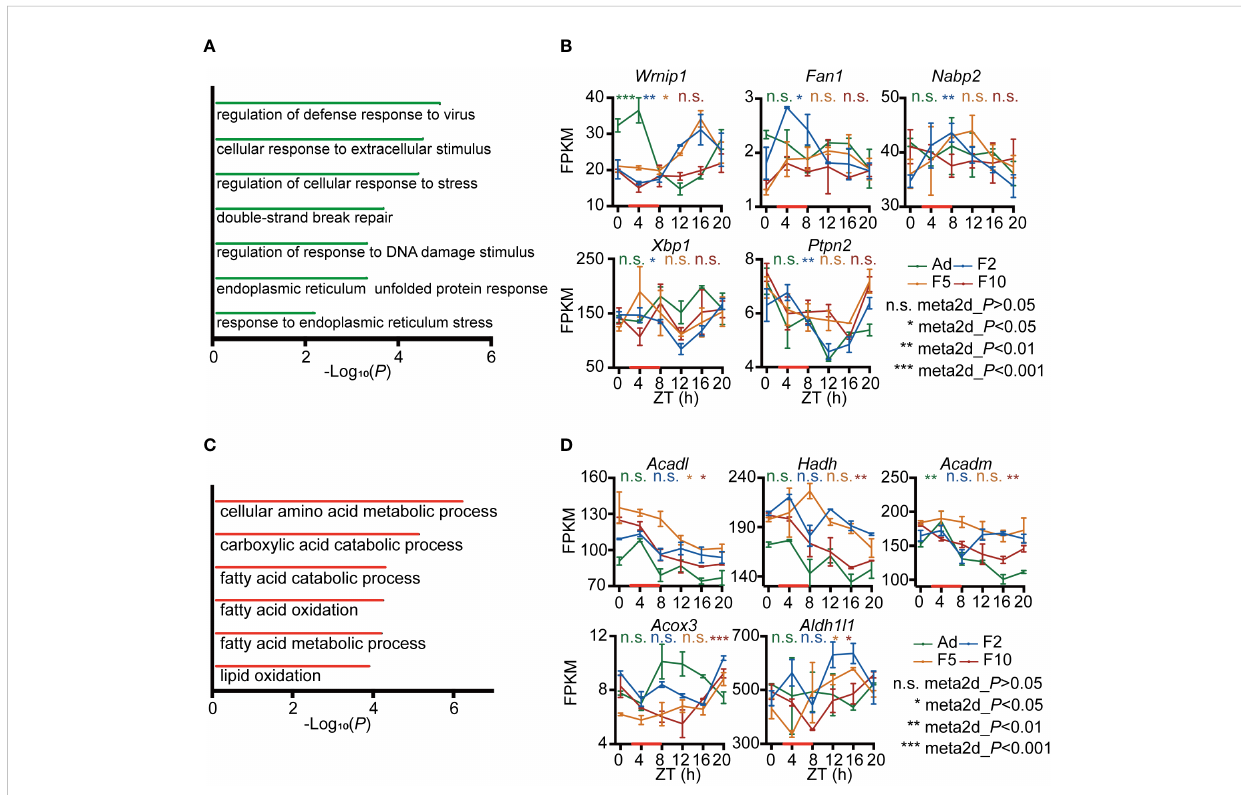
FIGURE 3 Functional analysis of genes with generational changes in rhythmicity. (A) Gene ontology (GO) biological process enrichment analysis of generational rhythm-loss genes during multigenerational DRF. (B) RNA-seq expression pro fi les of representative generational rhythm-loss genes involved in DNA damage and ER stress (n = 2). (C) GO biological process enrichment analysis of genes with generational rhythm-gain during multigenerational DRF. (D) RNA-seq expression pro fi les of representative generational rhythm-gain genes involved in fatty acid and lipid metabolism (n = 2). P-values were calculated using the meta2d algorithm; *P < 0.05; **P < 0.01; ***P < 0.001 were considered rhythmic; n.s., not rhythmic. Error bars represent the mean ±